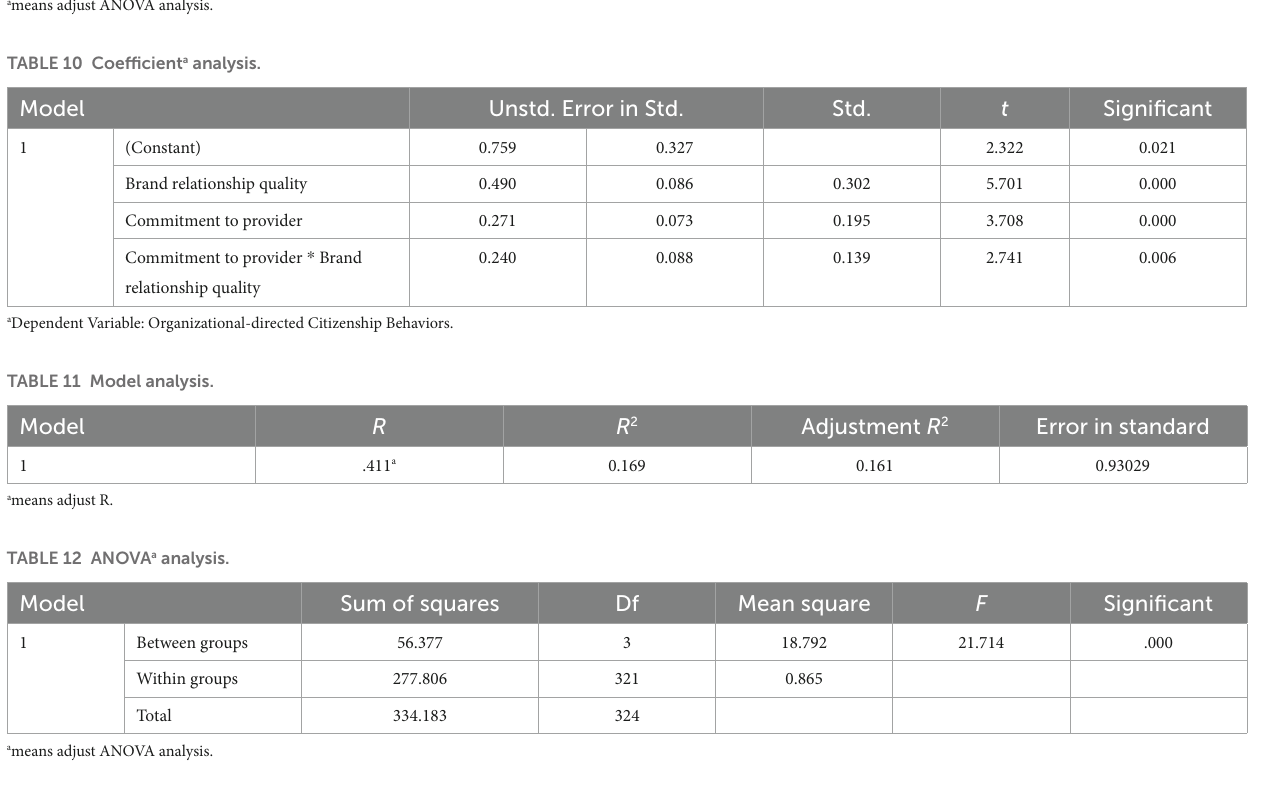
TABLE 13 Coefficient a